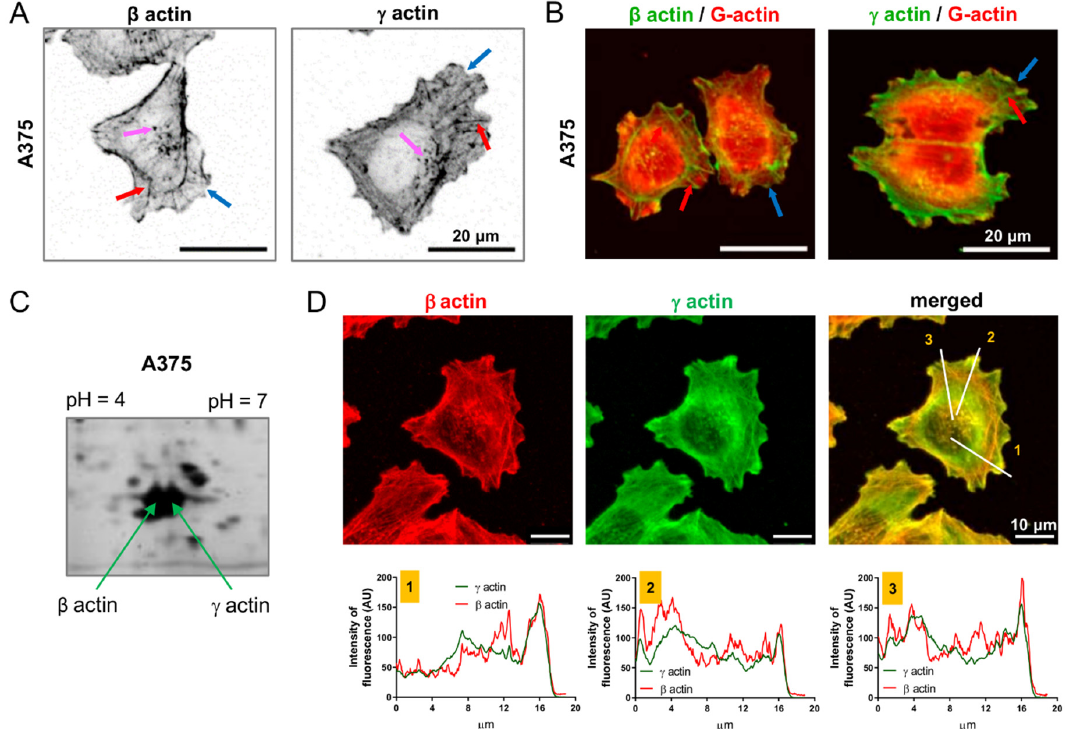
Figure 1. Differing distribution of non-muscle isoactins in A375 cells. ( A ) The cells were stained with antibodies detecting β and γ actin isoforms. Pink arrows point at invadopodia, red ones at stress fibers and blue ones at lamellipodia. ( B ) A375 cells growing on coverslips were fixed and stained to detect β or γ actin and globular actin by using appropriate antibodies and DNase I coupled to Alexa Fluor™ 594. Red arrows highlight stress fibers and blue ones lamellipodia. ( C ) Total protein extract from A375 cells (twenty μg of protein) was subjected to 2-D PAGE. The gel was stained with silver. ( D ) Immunocytochemically stained cells to detect β and γ actin. Three lines were drawn on a merged photo of the cell and the fluorescence histograms representing signal intensities for every fluorochrome were prepared on this basis.